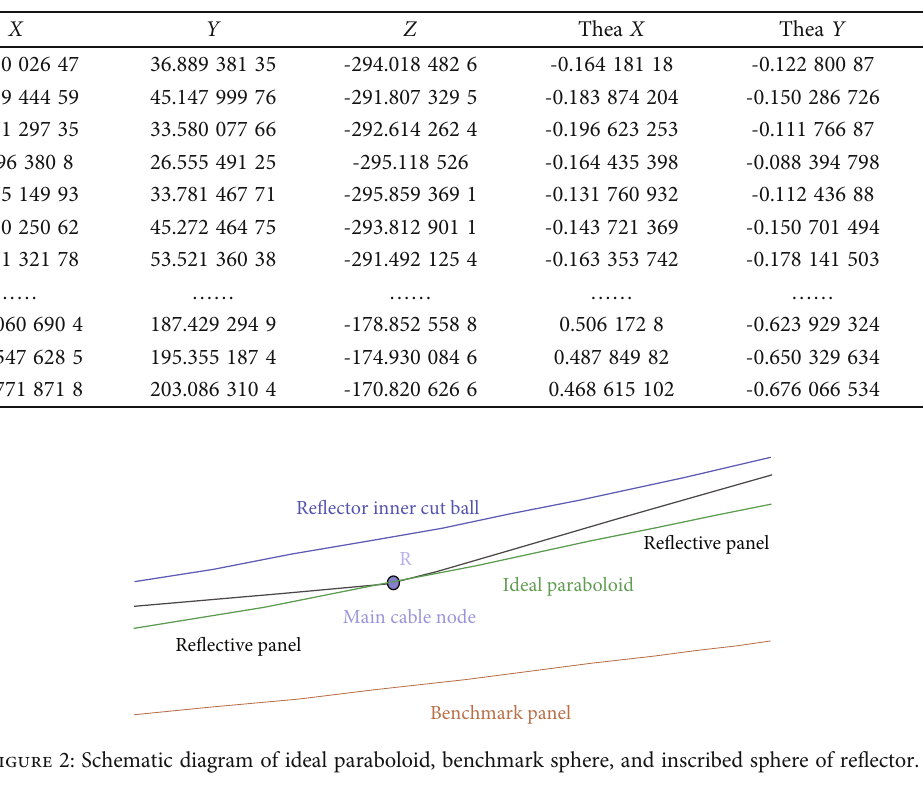
Actual offset point A ′′